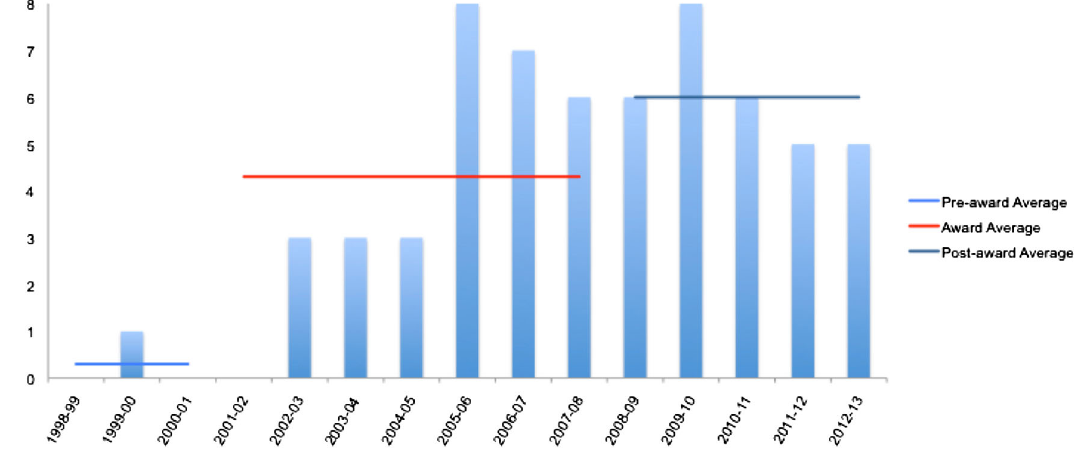
FIG. 2. PhysTEC secondary graduates from the University of Arkansas (UArk).